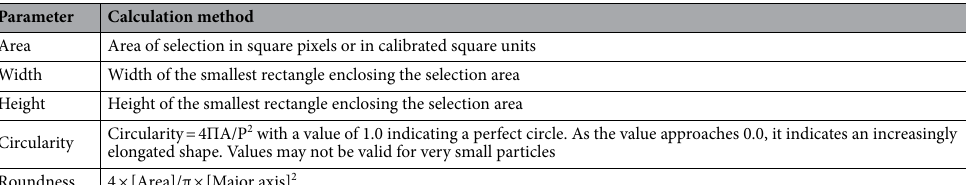
Table 1. Parameter definition and Calculation